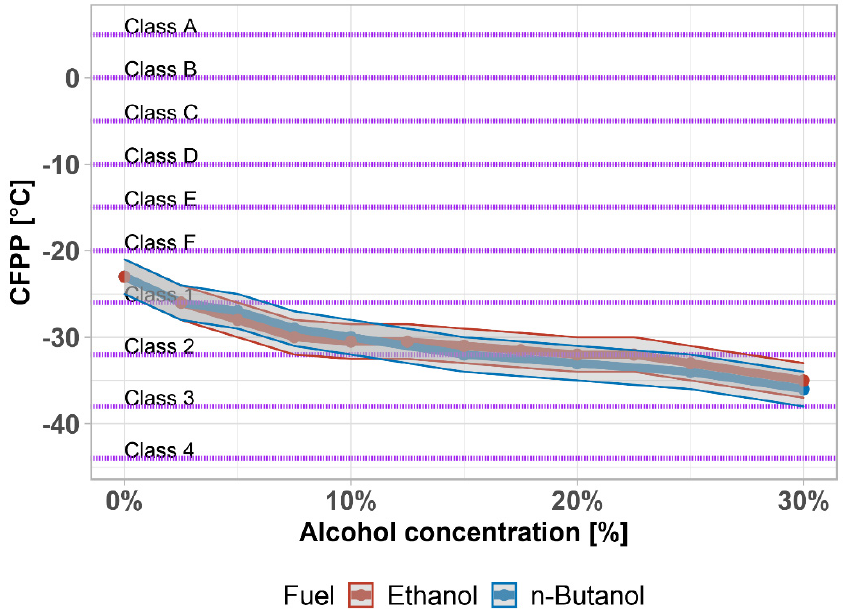
Figure 5. Cold filter plug point of diesel fuel–alcohol mixtures. Purple lines highlight the limit given by the standard.